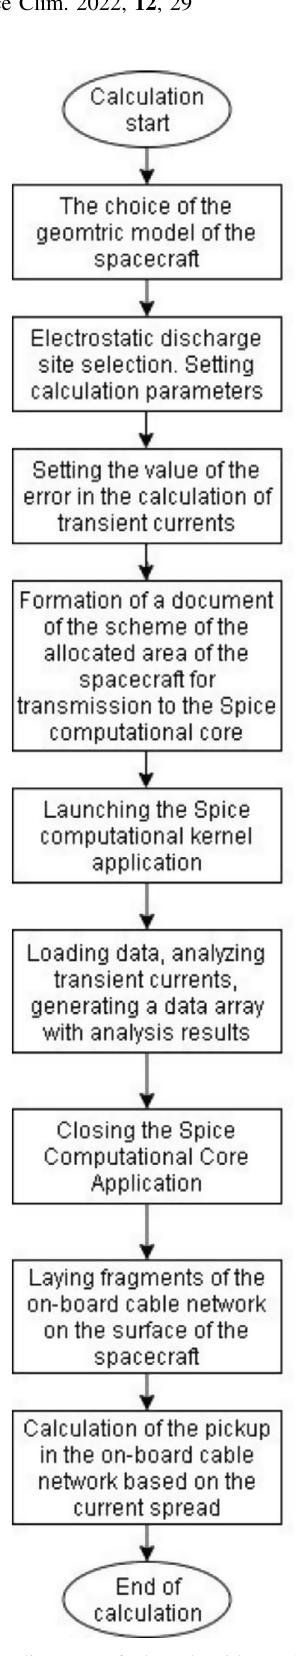
Figure 6. Block diagram of the algorithm of the method for calculating the interference in the selected area in the fragments of the